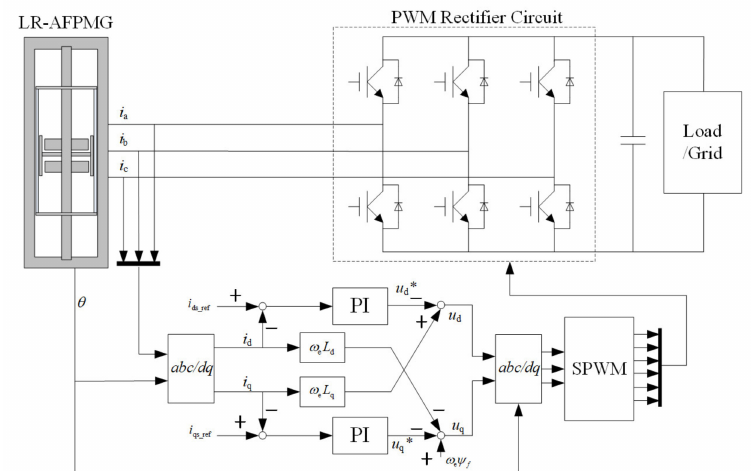
Figure 5. Current loop decoupling control block